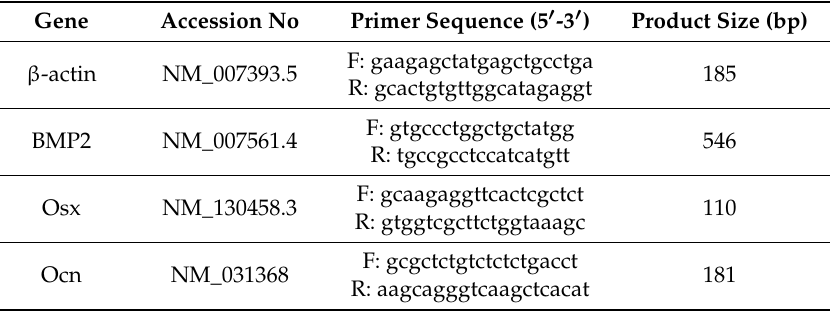
Table 1. Primers sequences for quantitative gene expression